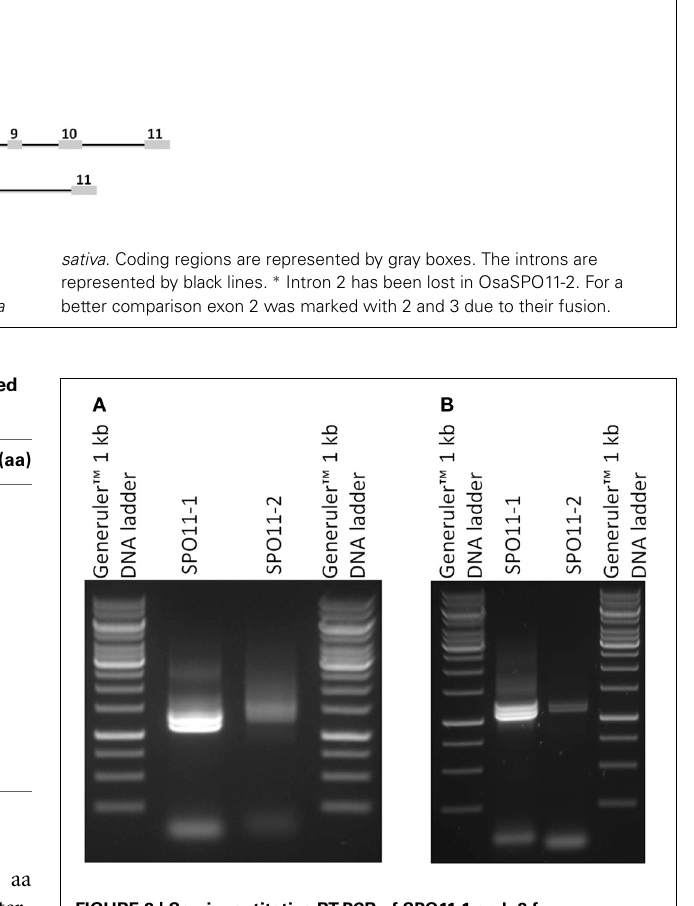
FIGURE 2 | Semiquantitative RT-PCR of SPO11-1 and -2 from Arabidopsis thaliana (A) and Brassica rapa (B). 1 μ l of each cDNA was used for the PCR reaction. In the case of SPO11-1, distinct bands are visible. The lower band represents the α form of SPO11-1, the others are a mixture of other forms. The same holds true for